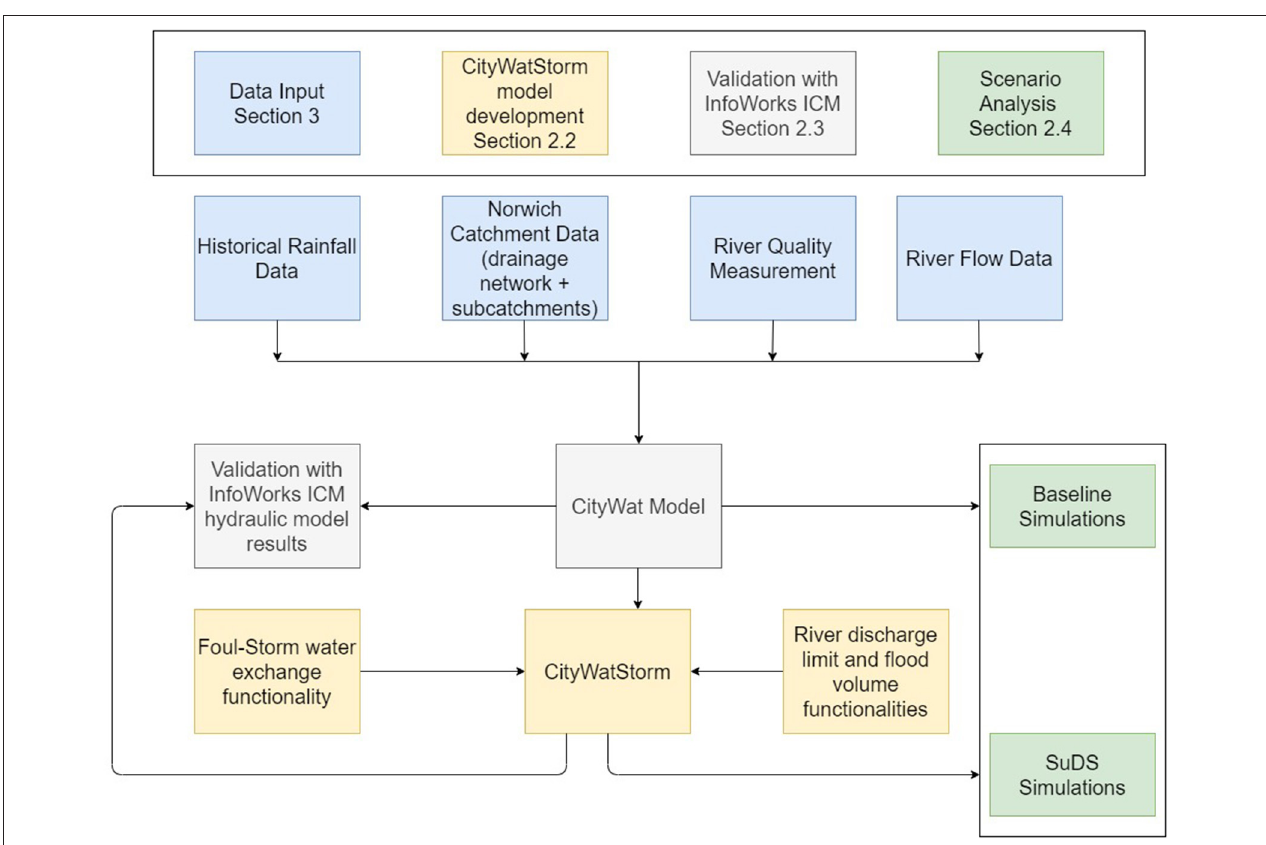
FIGURE 1 | Diagram of methodology for developing, validating, and simulating